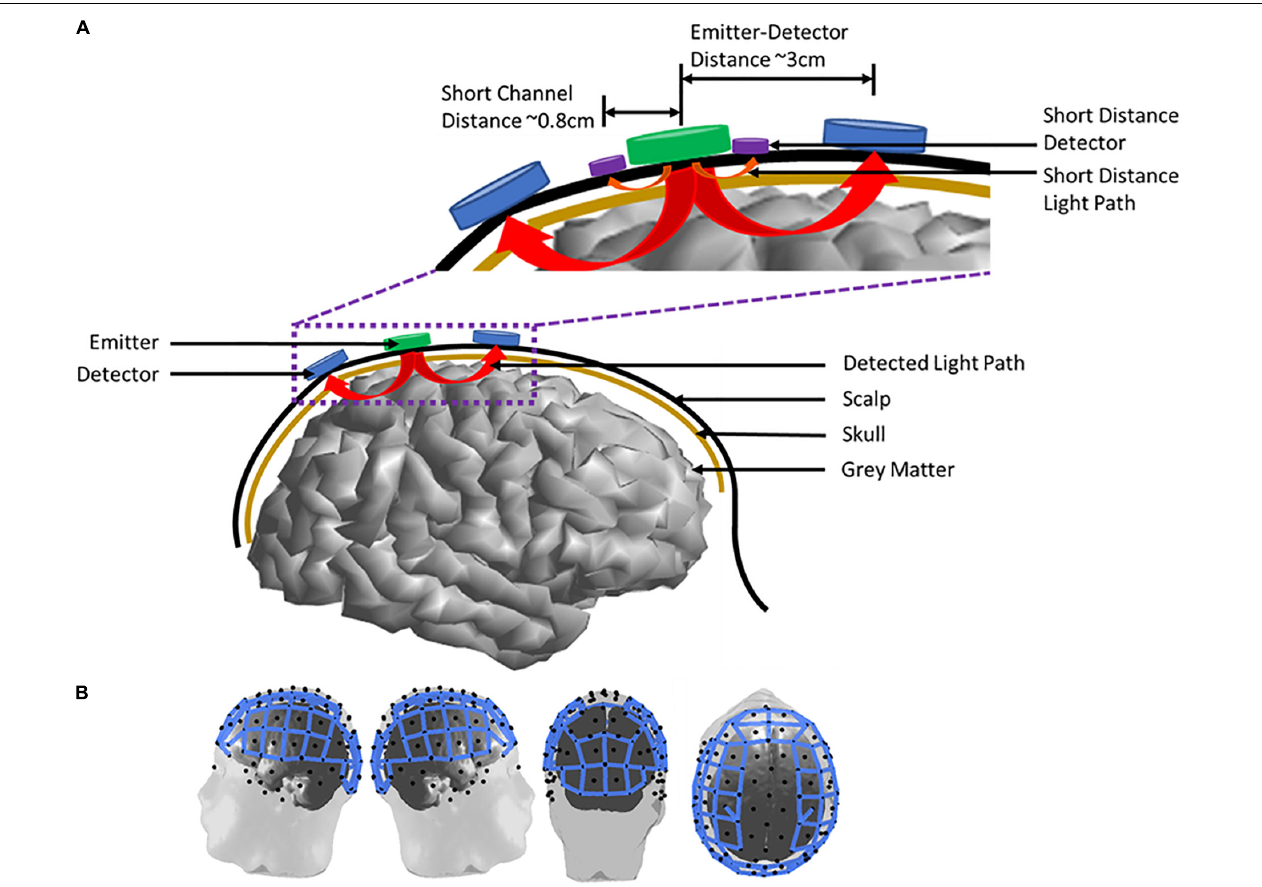
FIGURE 2 | Emitter and detector arrangement on an adult human subject. (A) A two channel emitter-detector pair placement on the scalp. Arrows from the emitter to the detectors indicate the measured light path of each channel. The inset highlights emitter-detector distances and the incorporation of short-distance channels to measure scalp blood flow. (B) Full head imaging cap example on an adult human subject. Blue lines represent measurement channels ( n = 102 channels) between emitter ( n = 32) and detector ( n = 32)